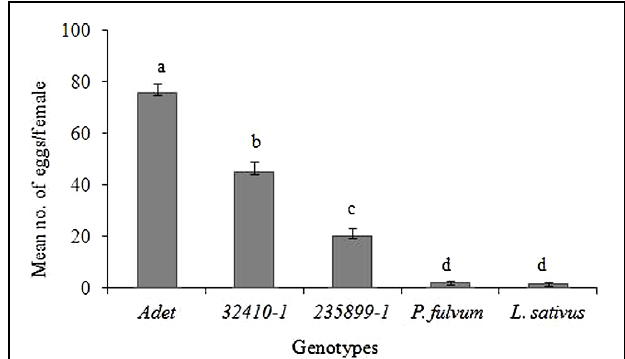
FIGURE 1 | Egg-laying activity (oviposition) of pea weevil females subjected to pods from Pisum sativum , Pisum fulvum and Lathyrus sativus genotypes in a no-choice test. Bars marked with different letters are significantly different (Tukey’s test: P < 0.001). Bars indicate mean ± standard error (SE).